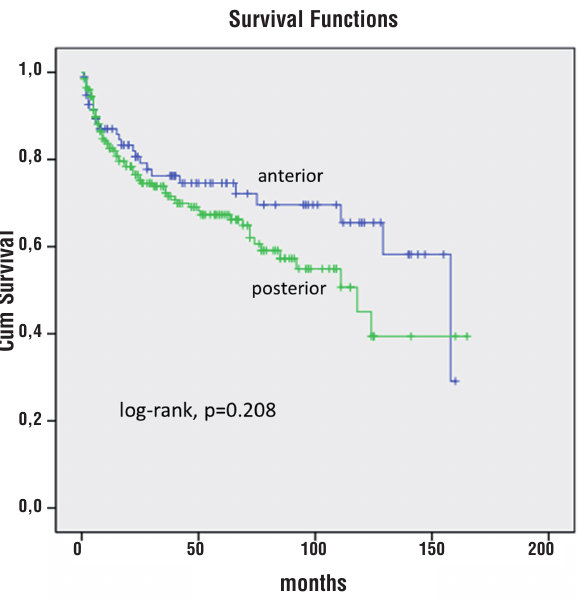
figure 2 - Kaplan-Meier product limit analysis shows time to psA biochemical progression-free outcome by index tumor anterior vs posterior predominant location. cum, cumulative.